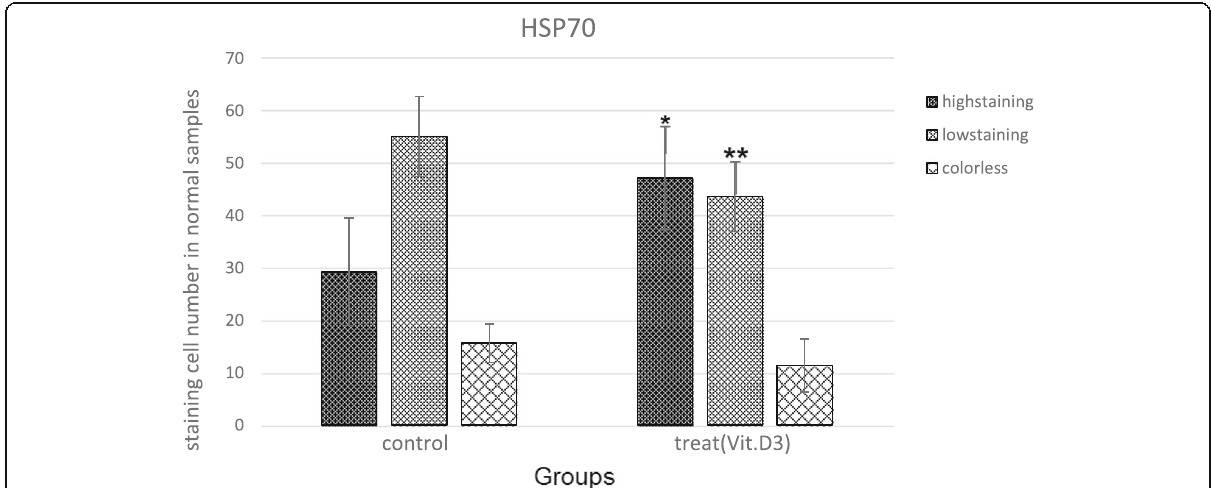
Fig. 2 Immunocytochemistry results for HSP70 protein in normal sample. Asterisk indicates a significant difference between the same type bars, *CI = 7.596 – 27.375 and **CI = − 19.63 to − 5.75